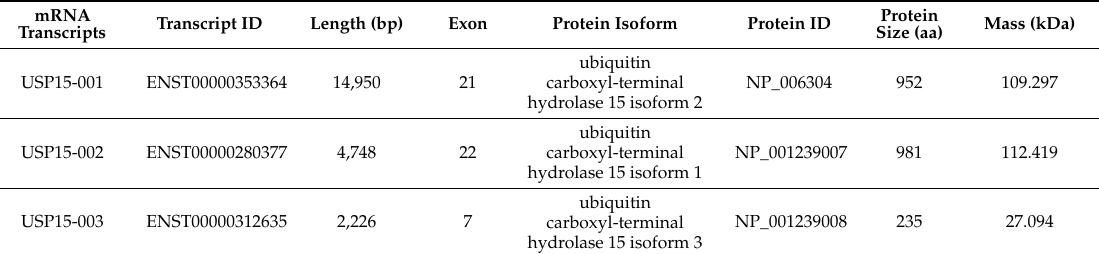
Table 1. Summary of three human USP15 mRNA transcripts and protein isoforms described by Ensembl genome database (available on: http://asia.ensembl.org/index.html) and UniProt database (available on: